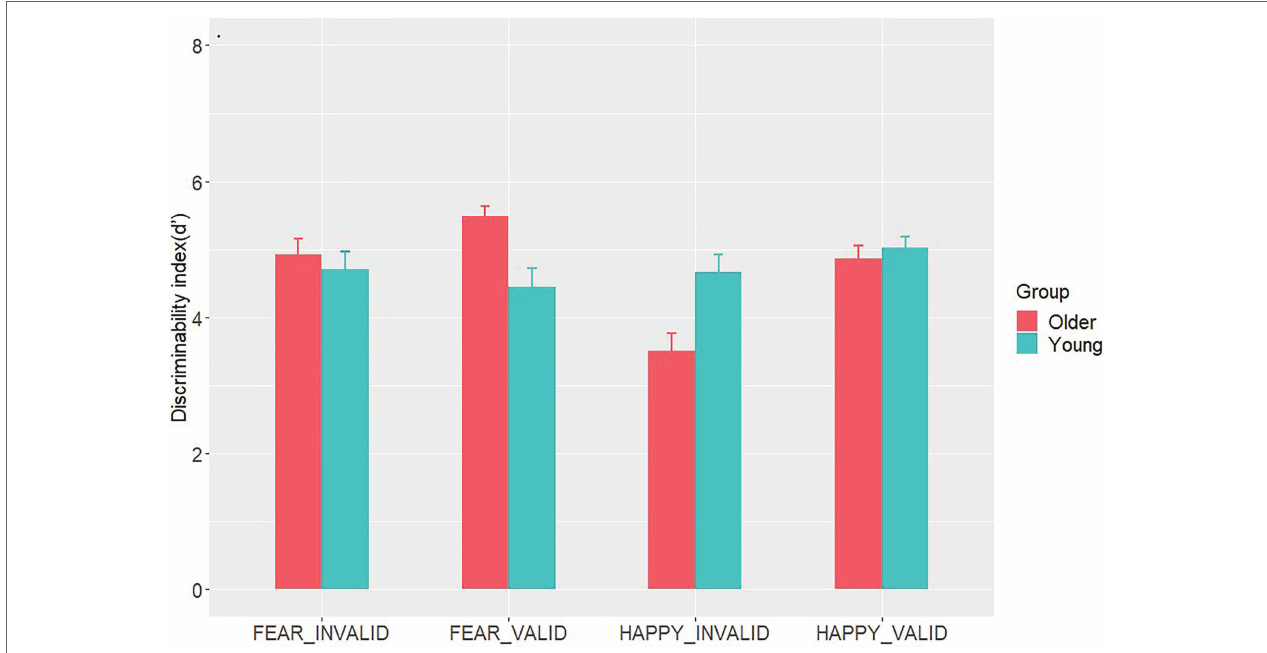
FIGURE 2 | The mean values of d ' in Go/No-go detection tasks for both age groups. The vertical lines above the bar stand for 1/2 Standard Error.